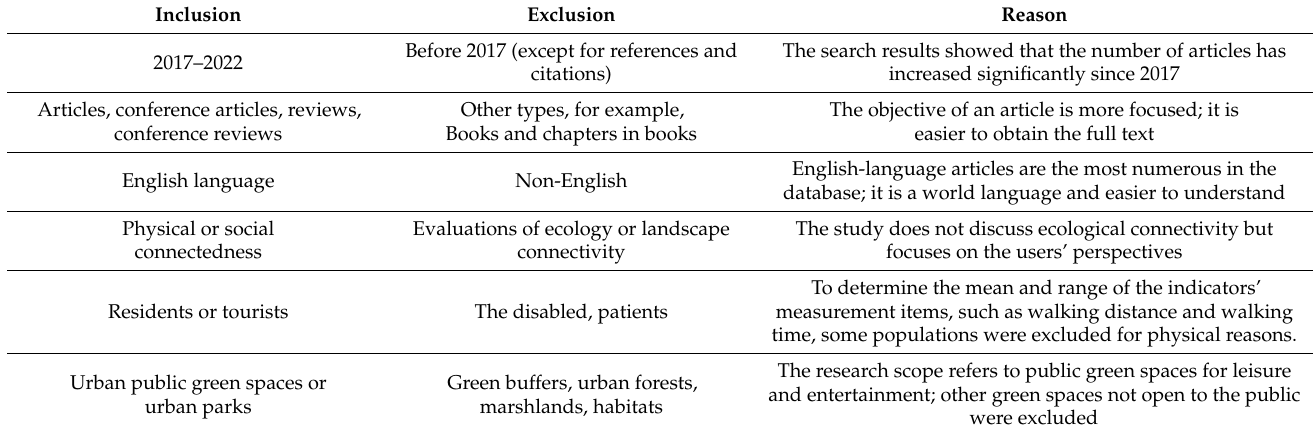
Table 2. Criteria and reasons for inclusion and